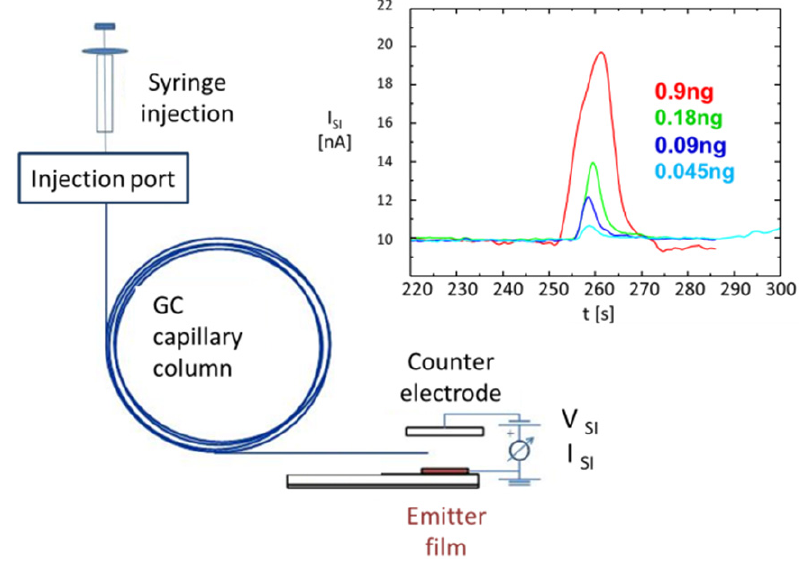
Figure 19. Injection of ephedrine into the air gap of an SI detector through a chromatographic column. The minimum detectable amount of ephedrine is less than 45 nanograms. Complete evaporation of this amount of ephedrine would yield a concentration of amine-containing molecules in the air gap in the high sub-ppm